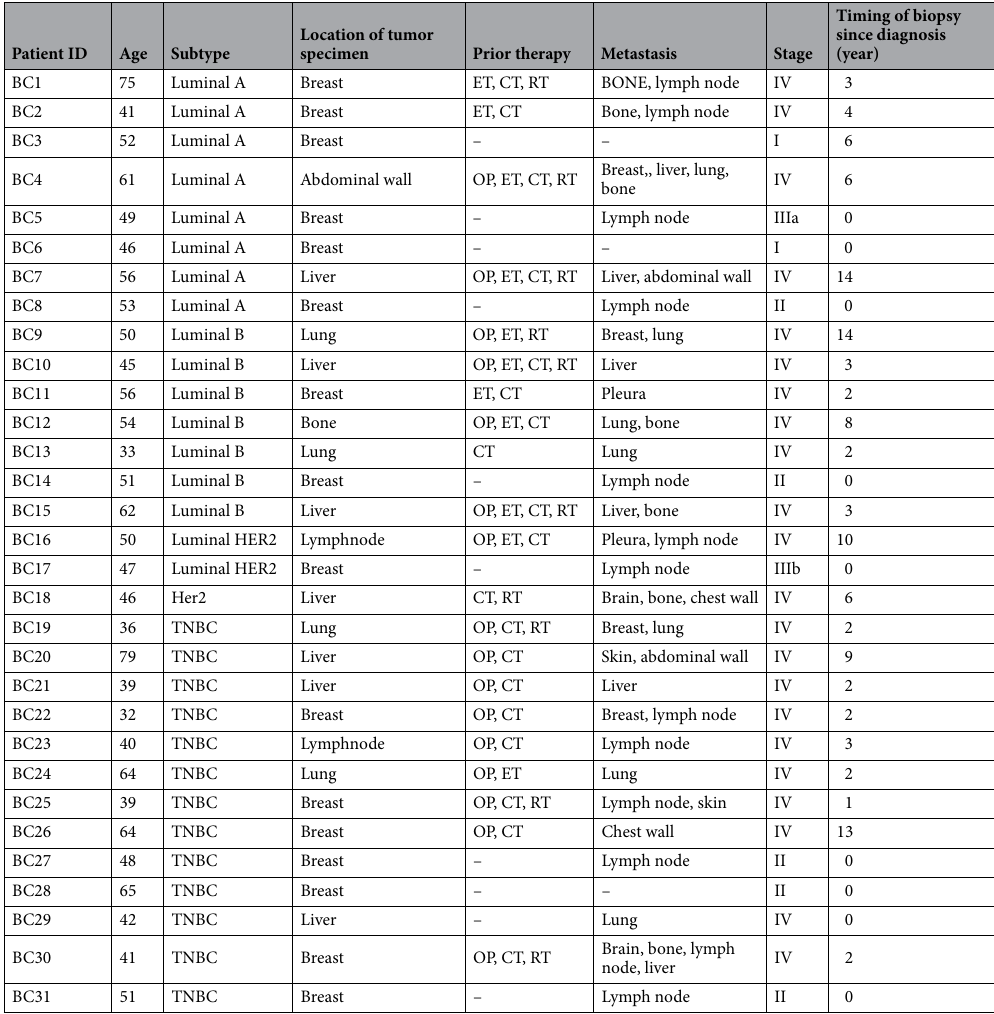
Table 1. Clinical characteristics of the breast cancer patients. Luminal A: luminal A type, Luminal B: luminal B type, HER2: HER2-positive type, TNBC: triple negative breast cancer, OP: operation, ET: endocrine therapy, CT: chemotherapy, RT: radiation